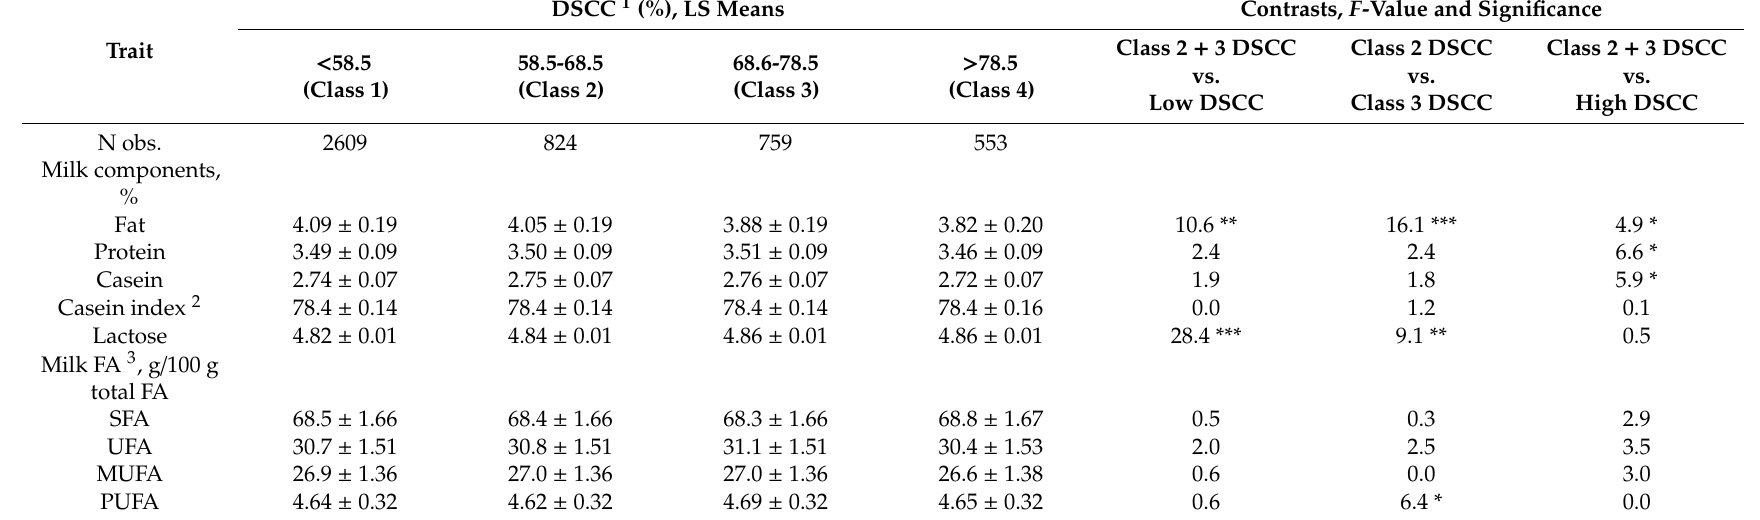
Table 5. LS Means and Standard Errors of DSCC ranges according to M-10 DSCC model for milk components and groups of fatty acids (FA), and their orthogonal contrasts ( F -value and